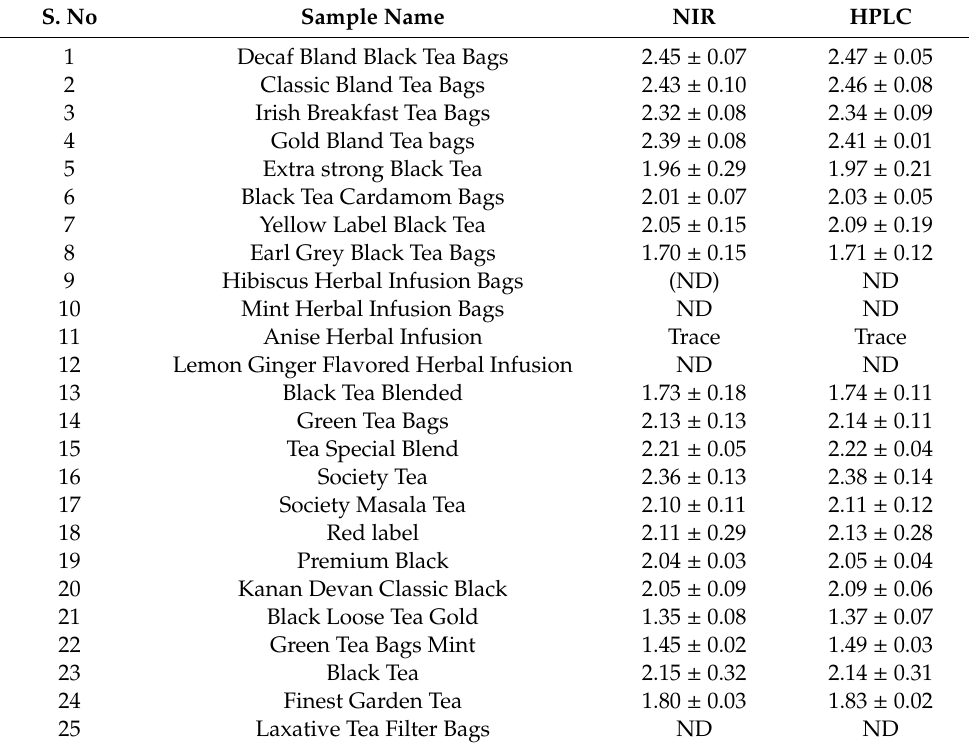
Table 2. The average content of ca ff eine in black tea infusions (g / 100 g ± SD), where SD stands for standard